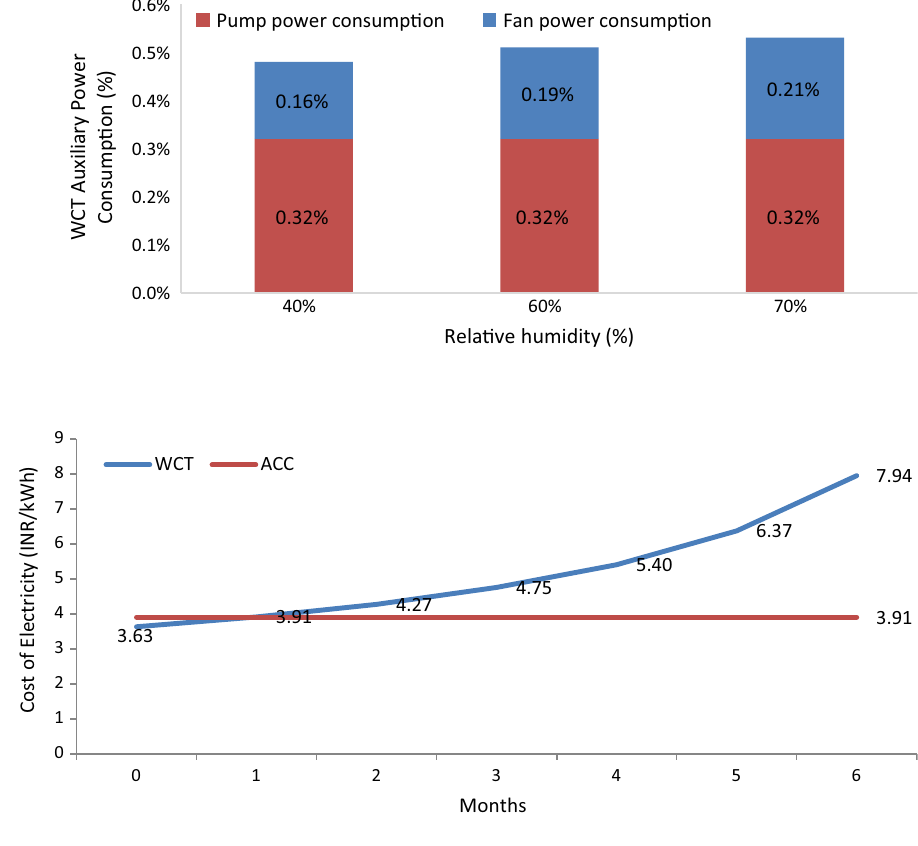
Fig. 6 Variation in cost of elec- tricity generation with number of months shutdown due to water